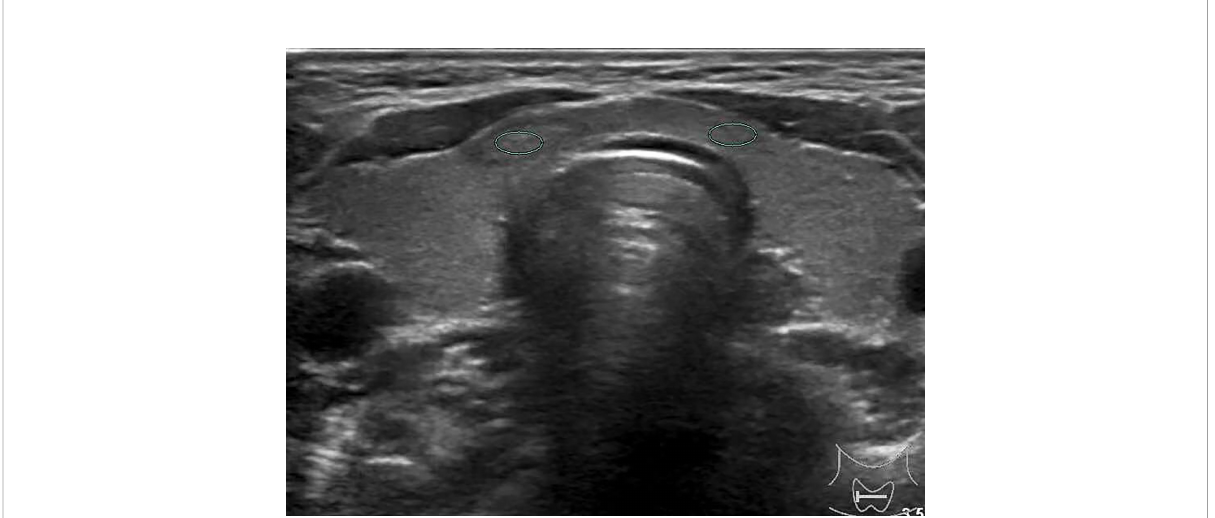
FIGURE 3 Female patient, 37 years old, 1-year case history of a thyroid nodule, pathology con fi rmed as nodular goiter with HT. TG-Ab = 1005.2 kU/L, TPO-Ab = 109.5kU/L, UGSR = 84.76/77.1 = 1.09945 (medical center